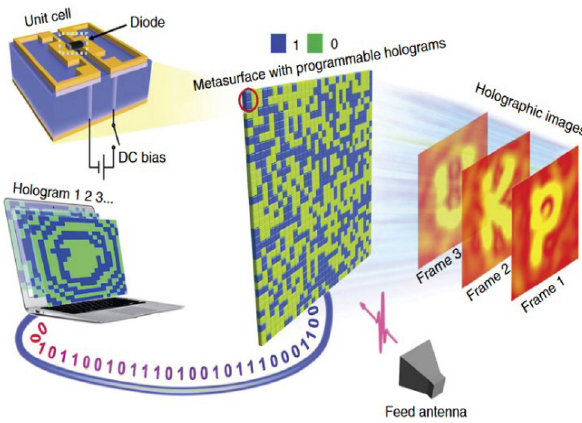
Figure 24: The schematic of the dual-polarization smart sensing metasurface[115].Reprintedfrom[115],withthepermissionofWILEY Publishing.©2020WILEY ‐ VCHVerlagGmbH&Co.KGaA,Weinheim.